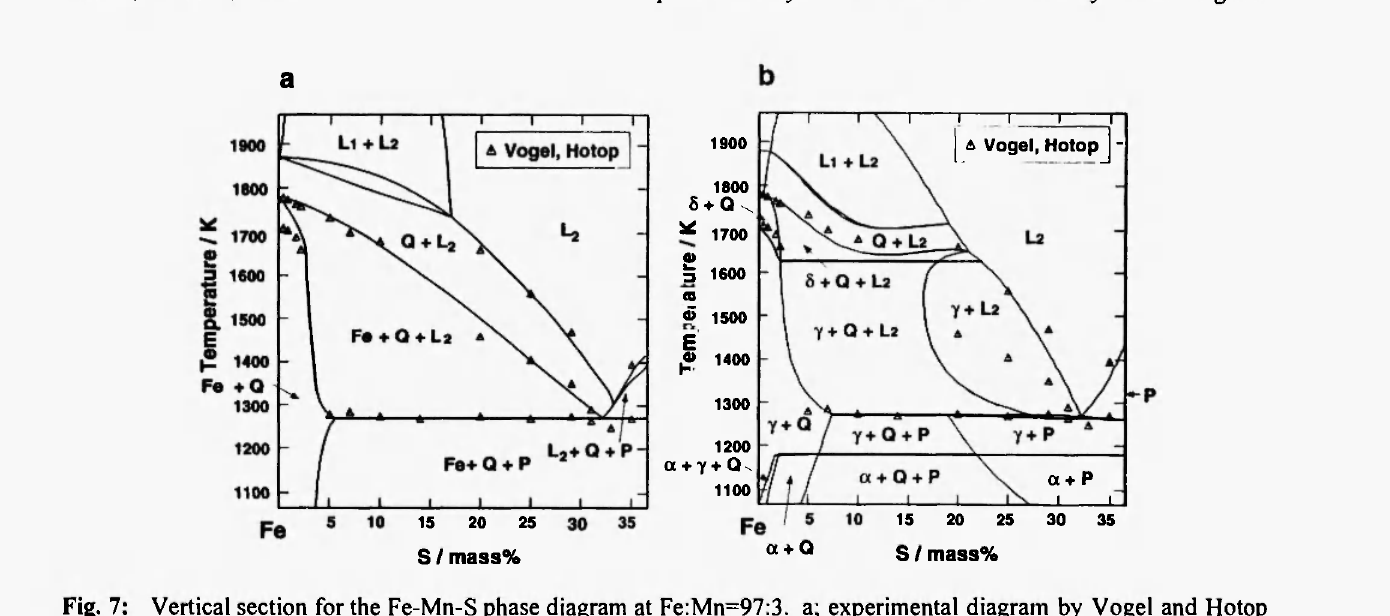
Fig. 7: Vertical section for the Fe-Mn-S phase diagram at Fe:Mn=97:3. a; experimental diagram by Vogel and Hotop /12/ and b; calculated diagram.